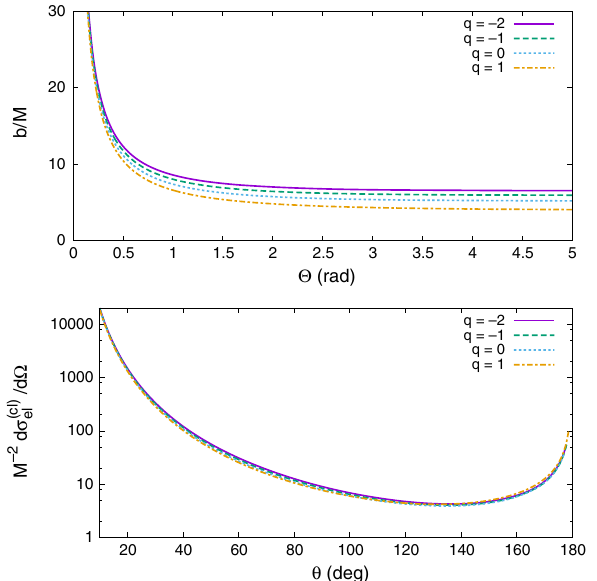
Fig. 1 Comparison of the deflection angle (top) and the null-geodesic differential scattering cross section (bottom) for black holes with q = − 2 , − 1 , 0 , 1